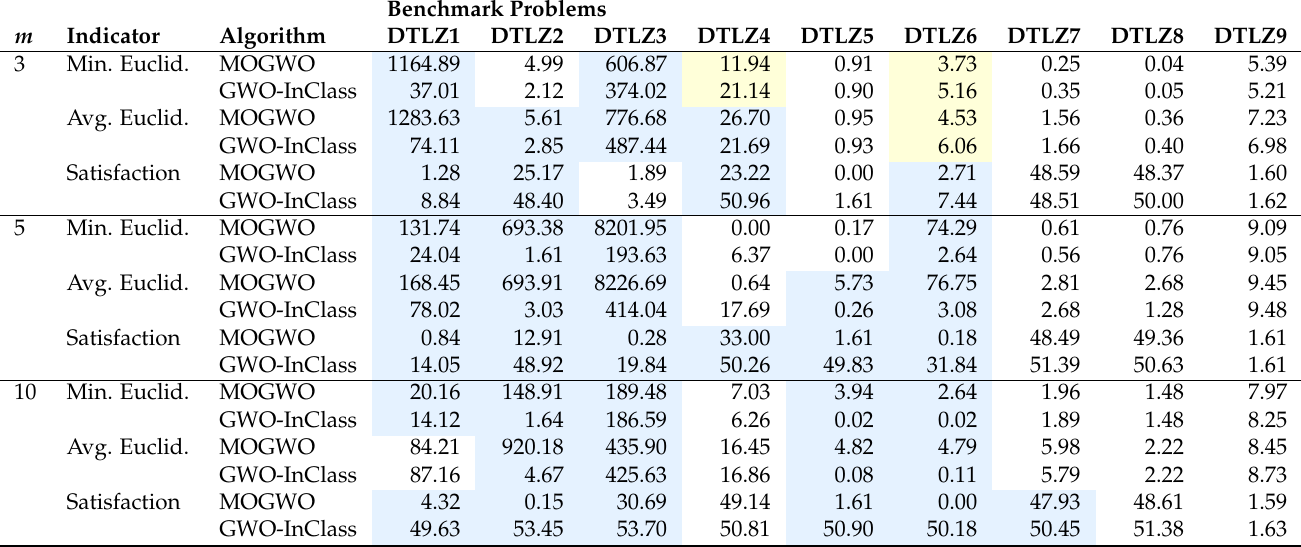
Table 1. Average results obtained by GWO-InClass and MOGWO. Benchmark